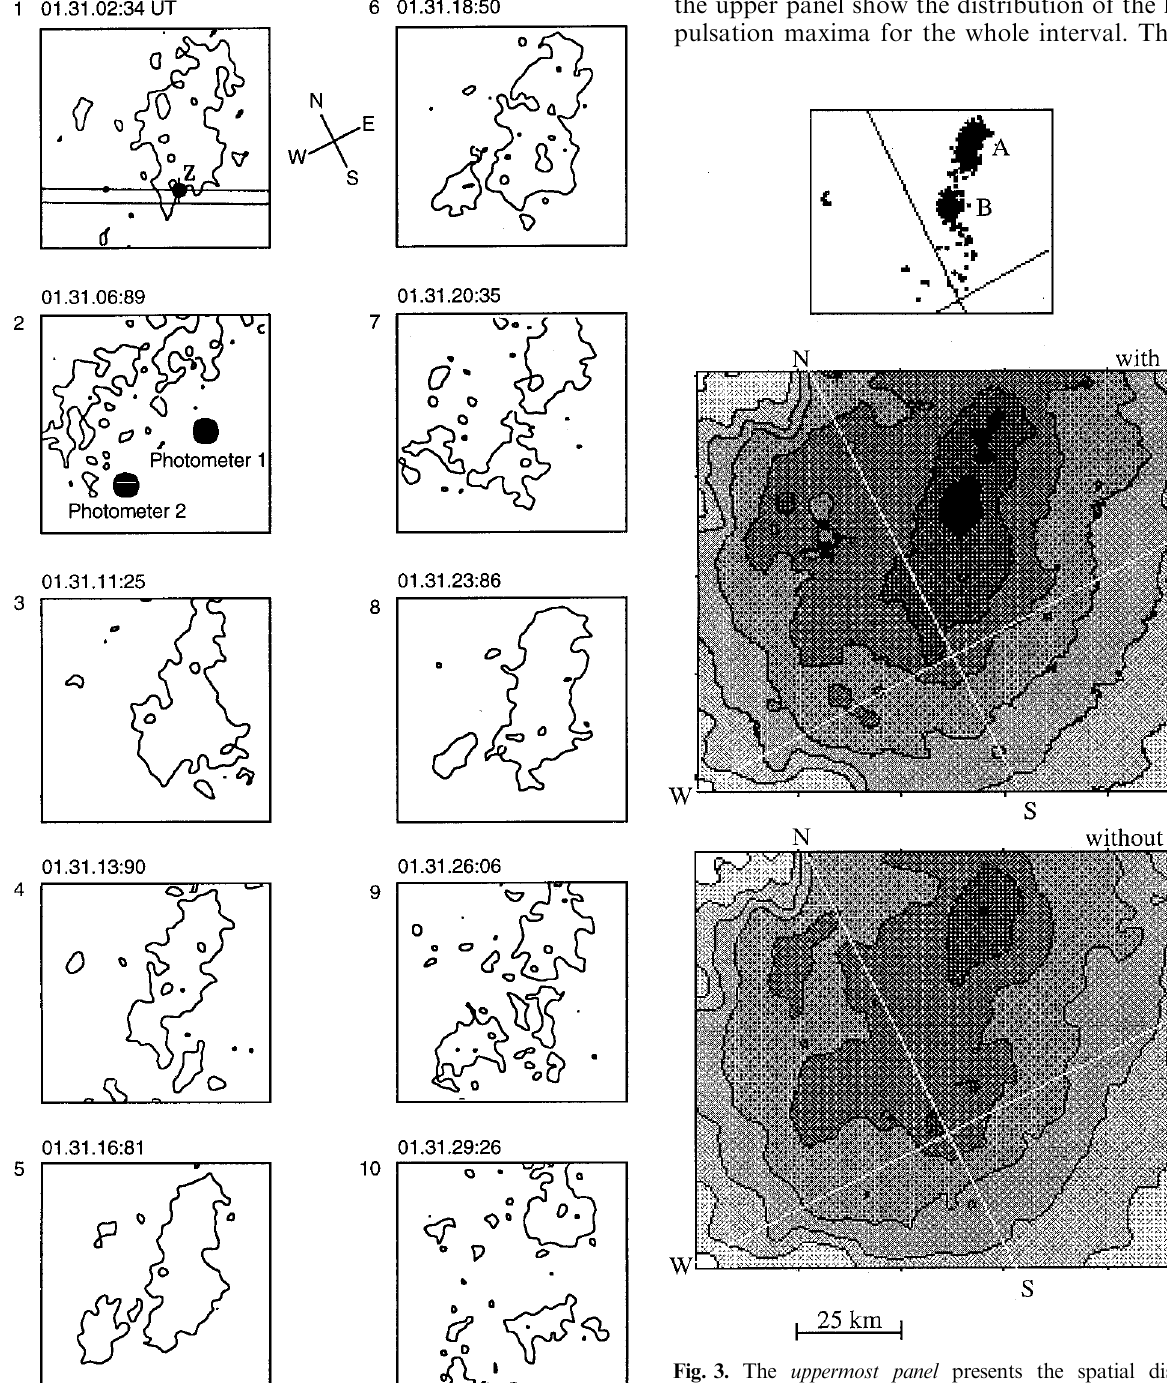
Fig. 2. The contours of the auroral patch for the moments indicated by triangles below the horizontal axis of the fourth panel in Fig. 1. The keogram direction is shown by lines in the first square Z means zenith. Assuming the average altitude about 95 km the horizontal dimensions of each square are about 130 · 130 km. The contours as in Fig. 1